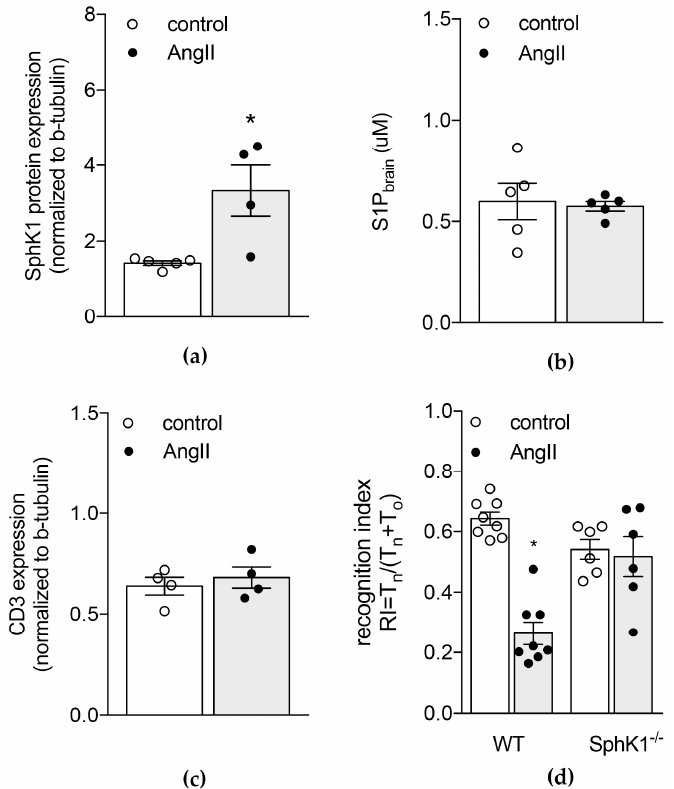
Figure 2. Genetic depletion of SphK1 protects from AngII-induced increases in brain S1P levels and memory deficits. ( a ) Western blot analysis of SphK1 protein expression in the brain of normotensive and hypertensive WT mice (corresponding Western blot images can be found in Figure S1b). ( b ) Mass spectrometry analysis of brain S1P levels in SphK1-deficient mice chronically perfused with AngII or saline. ( c ) Western blot analysis of brain CD3 protein expression in saline or AngII-treated SphK1-deficient mice (corresponding Western blot images can be found in Figure S3b). ( d ) Memory function of saline or AngII-treated SphK1-deficient and WT mice assessed in a NOR task with 24 h delay interval. Data expressed as mean ± SEM; n = 4–8 per group * p < 0.05 after single unpaired